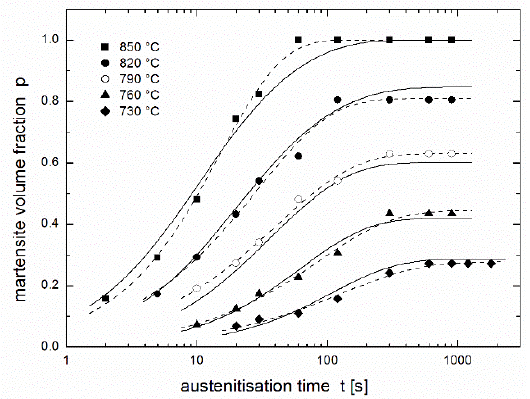
Figure 3. Martensite volume fraction in dual phase steel after austenitisation at various temperatures during various dwells [17]: comparison of fits using the equation of autoinhibition (full lines) and the JMAK equation (dashed lines).